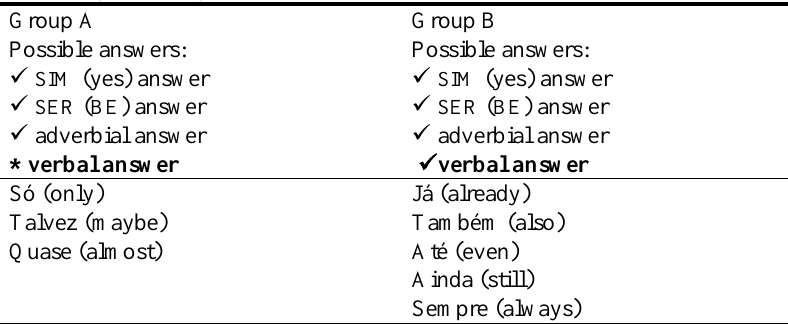
Table I. Possible answers to yes-no questions with different adverbs in preverbal